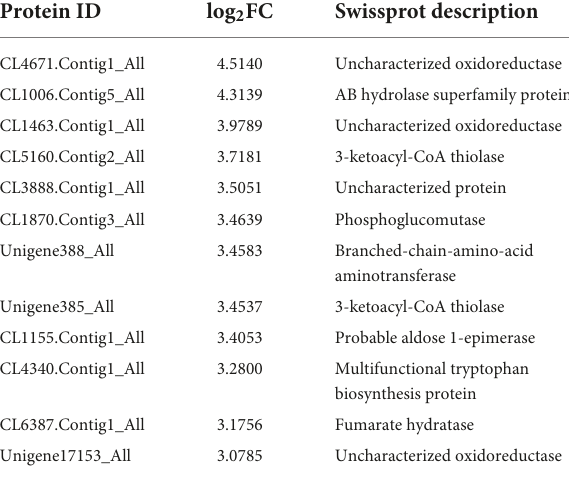
TABLE 3 Highly differentially abundant proteins in the “biosynthesis of antibiotic” pathway. Protein